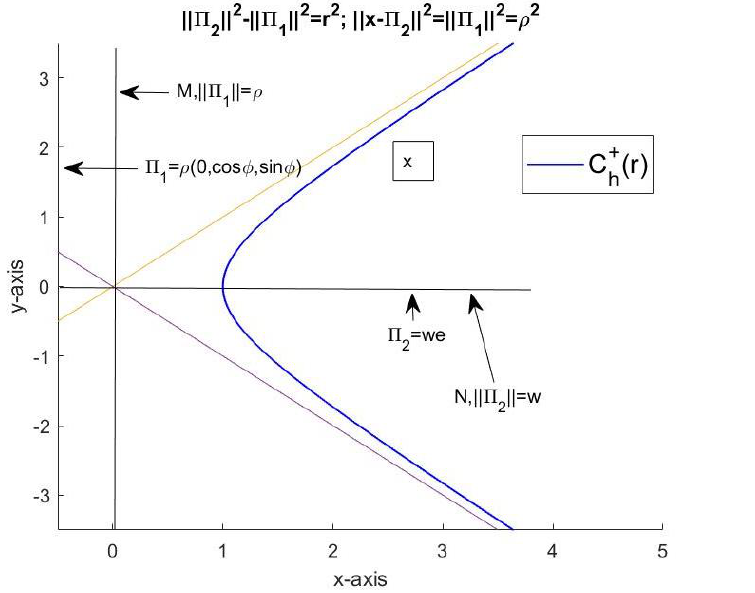
Figure 8. Three − dimensional space − time: the hyperbola rotates around the y − axis. If the angle ϕ runs through the interval [ 0, 2 π ) , then the point x runs through an Euclidean circle of radius (cid:36) , centered at the point w • e and belonging to the two-dimensional plane being parallel to the subspace M